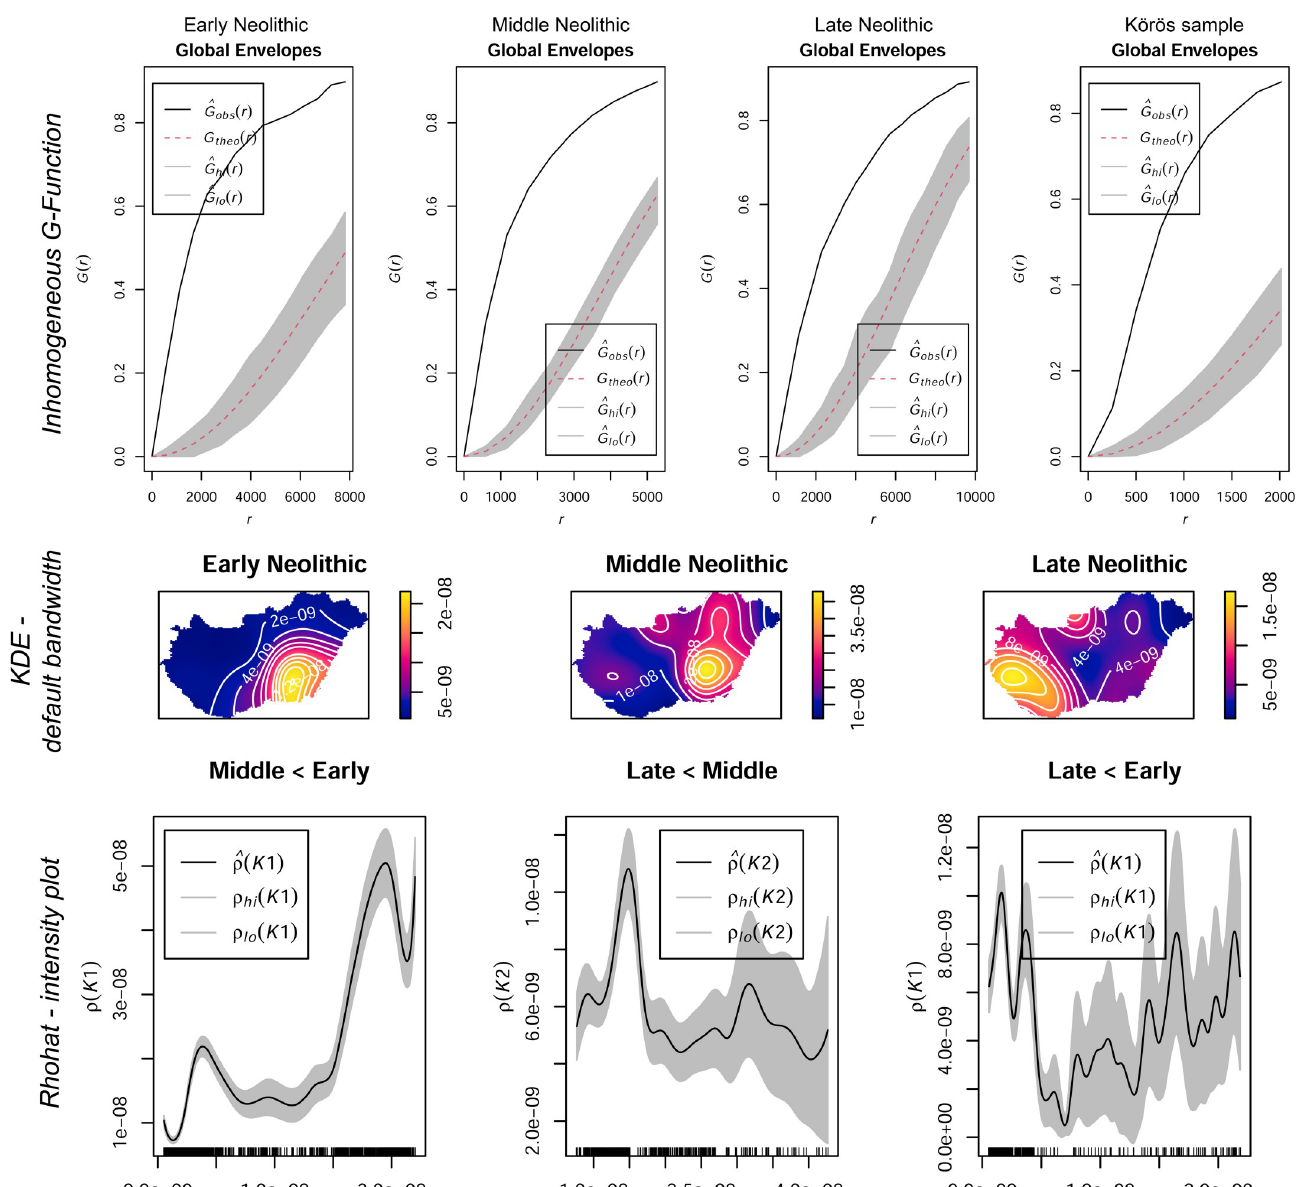
Fig 4. Point pattern analysis. Upper part: Envelope simulation of the G-Function for Early, Middle, and Late Neolithic sites as well as the Ko¨ro¨s comparison sample. All observed samples show significant clustering above the envelope. Middle part: default bandwidth kernel density estimation of the sites. Lower part: Rhohat intensity plot using spatial point pattern and site distribution density as explanatory covariate. The function measures whether the Middle Neolithic site distribution is a function of the previous Early Neolithic site distribution (LN/MN and LN/EN respectively).